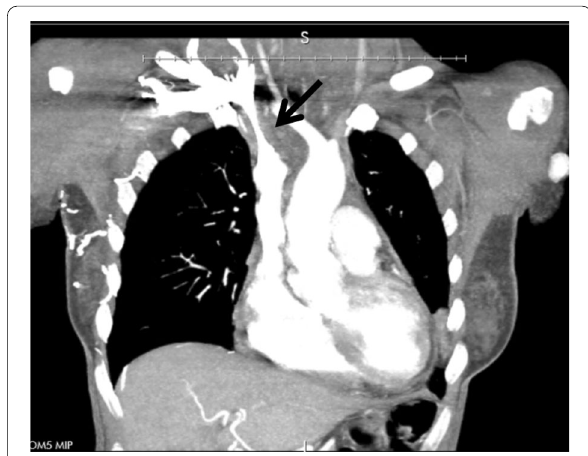
Fig. 1 A computed tomography scan of the chest identified